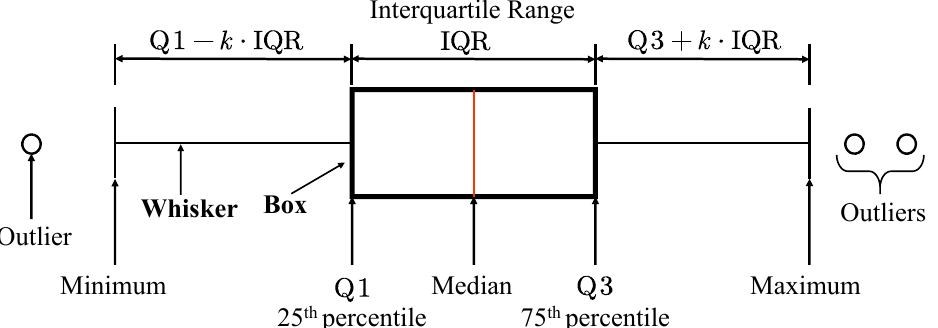
Figure 1. Schematic presentation of Box and Whisker plot. The value of k in the figure is 1.5, if you use the function matplotlib.pyplot.boxplot or pandas.DataFrame.boxplot in Python to generate it.